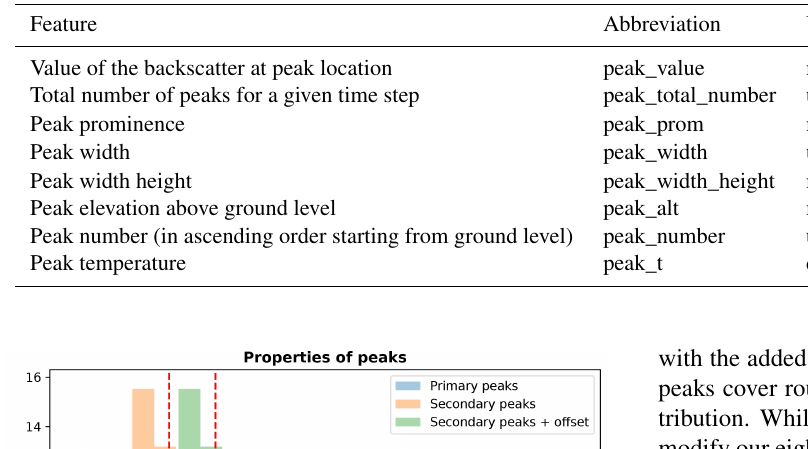
Table 1. Features of peak properties, including full name, abbreviations, and units.